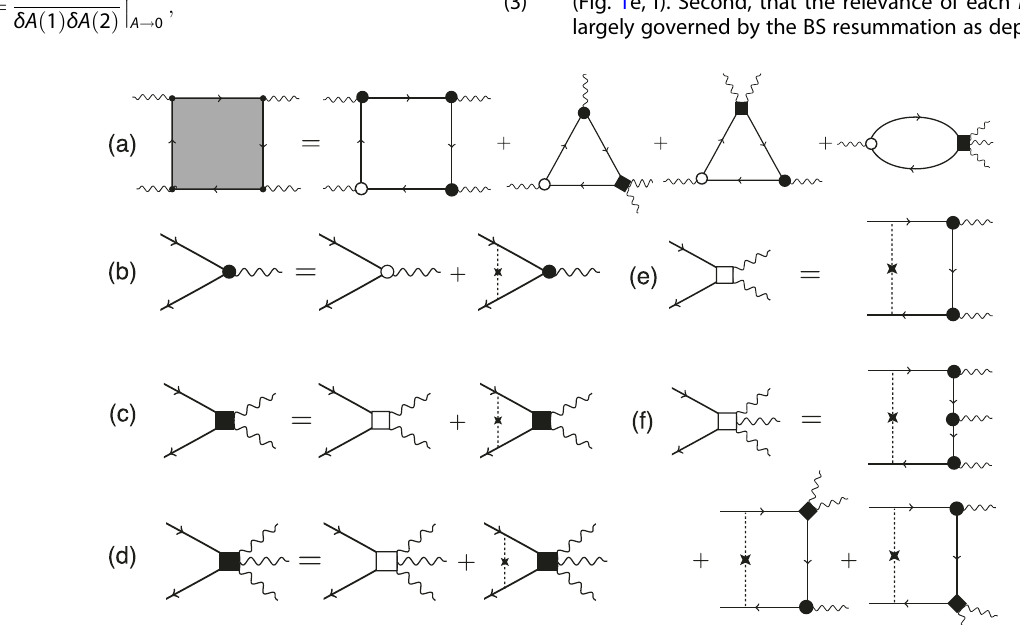
Fig. 1 Diagrammatic representation of nonlinear e.m. response in Dirac materials. a nonlinear response expressed in terms of renormalized n -photon vertices; b – d self-consistent Bethe – Salpeter equations for one-, two- and three-photon vertices; e – f many-body de fi nition of unrenormalized two- and three-photon vertices in terms of lower-order vertices. Solid and wavy lines stand for fermion propagator and external photons, respectively. Dashed lines indicate impurity interaction. Empty/ fi lled circles stand for bare/renormalized one-photon vertex, respectively. Empty/ fi lled squares stand for unrenormalized/renormalized two and three-photon